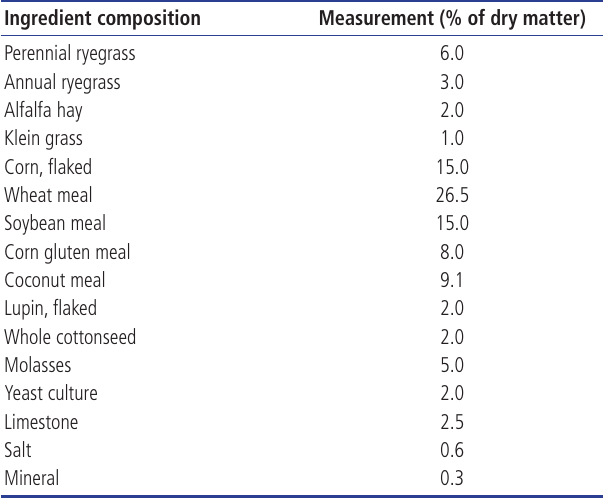
Table 1. Ingredient composition of experimental